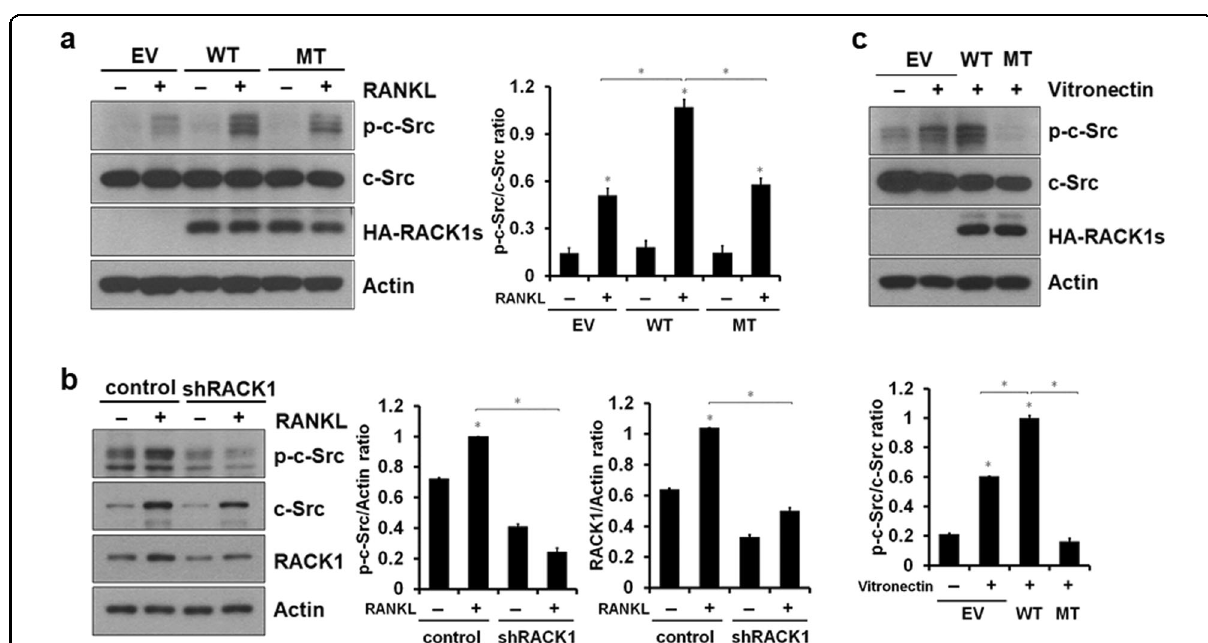
Fig. 3 RACK1 regulates RANKL-induced c-Src activation. a Mature osteoclasts generated from BMMs were serum-starved and stimulated with 200 ng/mL RANKL for 20 min. Whole cell lysates were analyzed using western blotting with anti-phospho-c-Src, anti-c-Src, anti-HA, and anti-actin. The ratio of p-c-Src to total c-Src proteins was quanti fi ed from each of three independent experiments. * P < 0.01. b BMMs transduced with pMX-puro control shRNA (control) or pMX-puro-shRACK1 (shRACK1) retrovirus were cultured for 3 days with 30 ng/mL M-CSF and 100 ng/mL RANKL to generate mature osteoclasts. Protein levels were analyzed using western blotting with antibodies speci fi c for the indicated proteins. The ratios of p-c- Src to actin and RACK1 to actin were quanti fi ed from each of three independent experiments. * P < 0.01. c Mature osteoclasts generated from BMMs were cultured with 30 ng/mL M-CSF and 100 ng/mL RANKL for 4 days. After the cells were removed, they were either maintained in suspension or plated on a vitronectin-coated dish for 30 min. Cell lysates were analyzed using western blotting with antibodies against anti-phospho-c-Src,